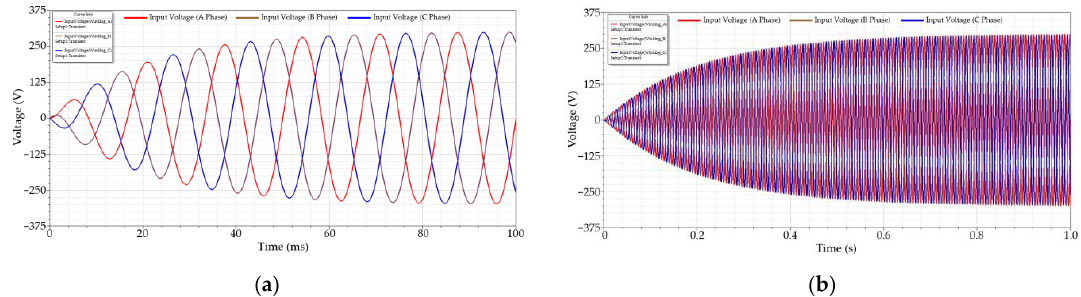
Figure 6. Simulation results of the winding voltage under the conventional equation. ( a ) 𝛽 = 50 ; ( b ) 𝛽 = 5.